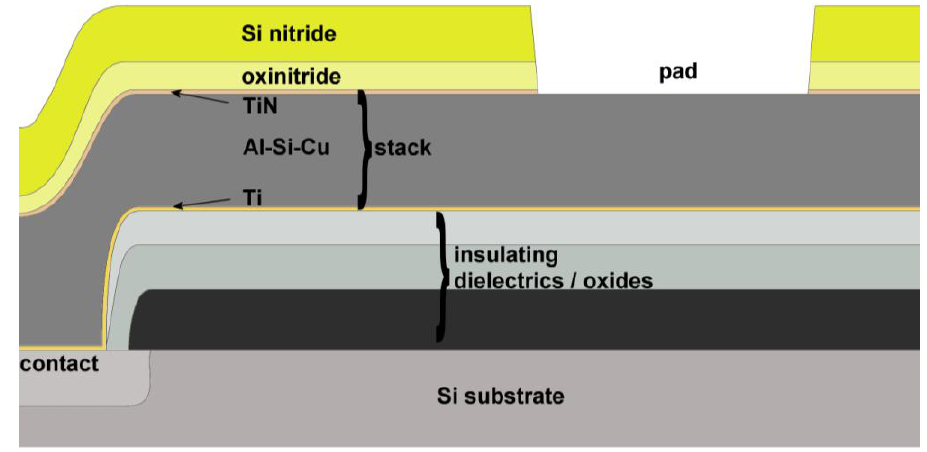
Figure 3. Typical CMOS metallisation (simplified, and for brevity showing only single-layer metal). The thickness of the marked ‘stack’ is typically 1 μm and here comprises a titanium barrier layer, an alloy of Al-Si-Cu and a titanium nitride anti-reflective